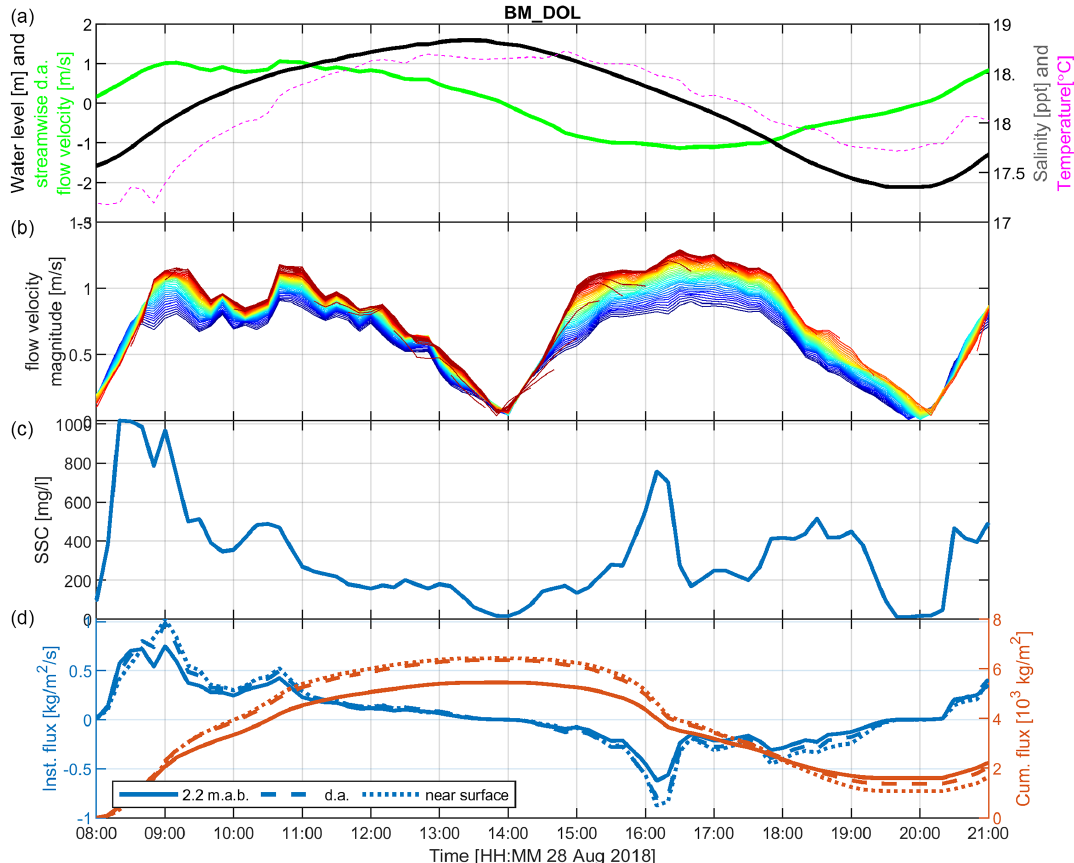
Figure 12. Tidal cycle observations at the mouth of the Dollard (BM_DOL), showing the water level (black), salinity (grey), depth-averaged flow velocity (green), and temperature (pink, a ), the depth-varying flow velocity (red near the surface, blue near the bed, b ), the sediment concentration near the bed (c) , and instantaneous and cumulative sediment flux (landwards positive; d